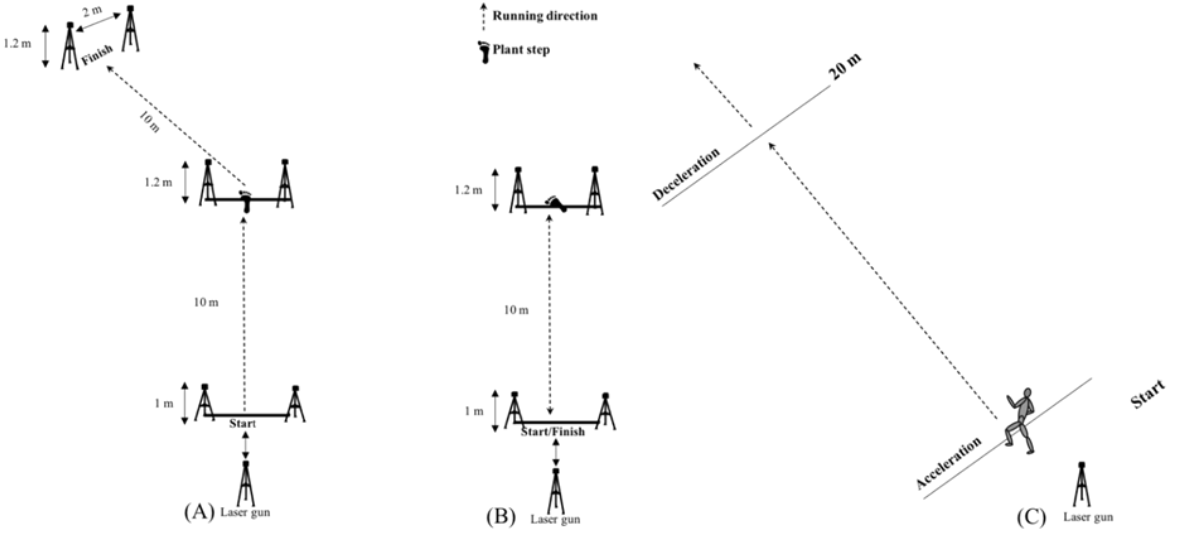
◦ ( B ) and 180 ◦ ( C ) COD